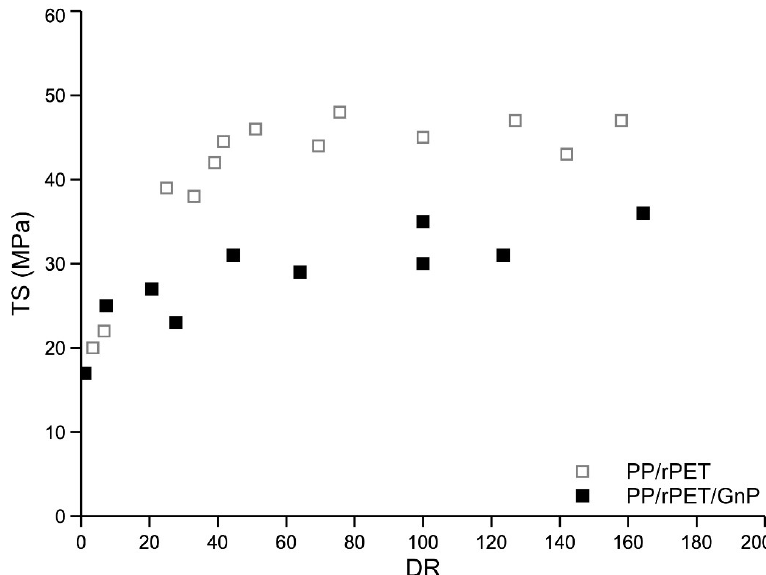
Figure 9. Tensile strength as a function of the draw ratio.